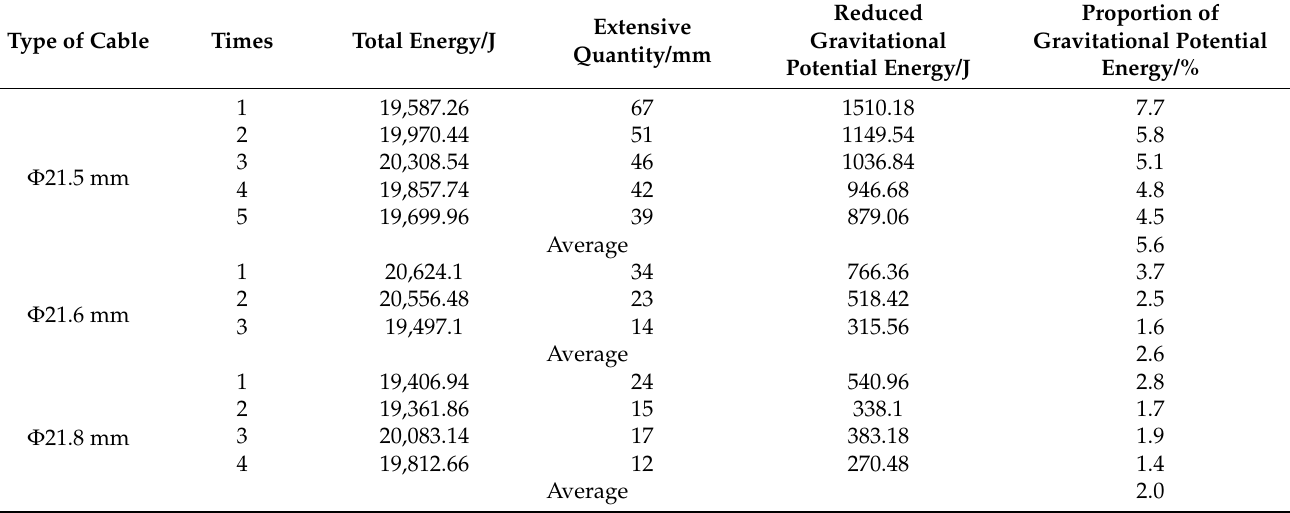
Table 5. Loss ratio of gravitational potential energy.